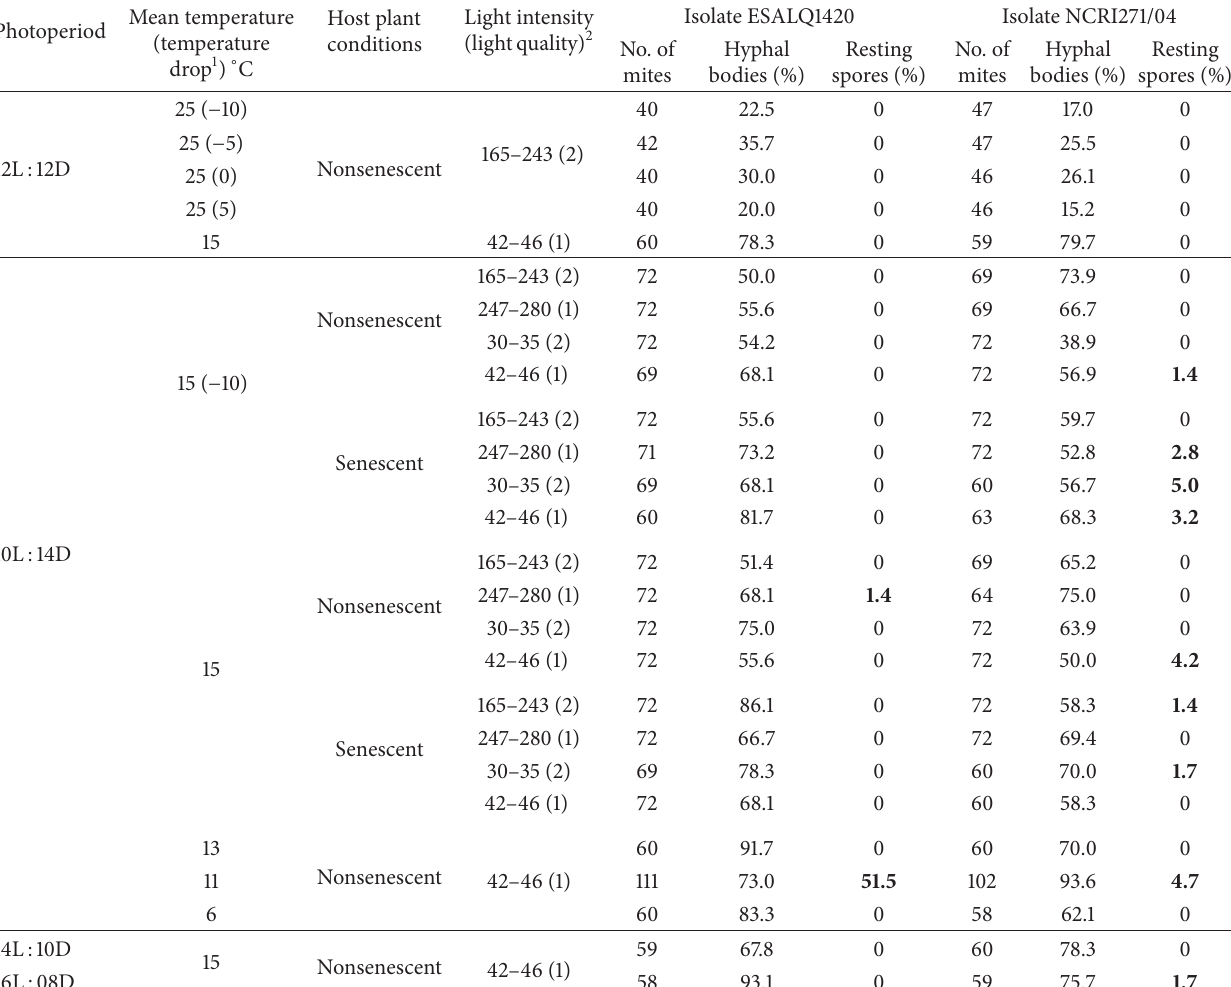
Table 1: Effect of different combinations of photoperiod, mean temperature, temperature drop, light intensity, and light quality on resting spores produced in N. floridana -killed T. urticae by one isolate from Norway (NCRI271/04) and one from Brazil (ESALQ1420). Mean temperature Photoperiod